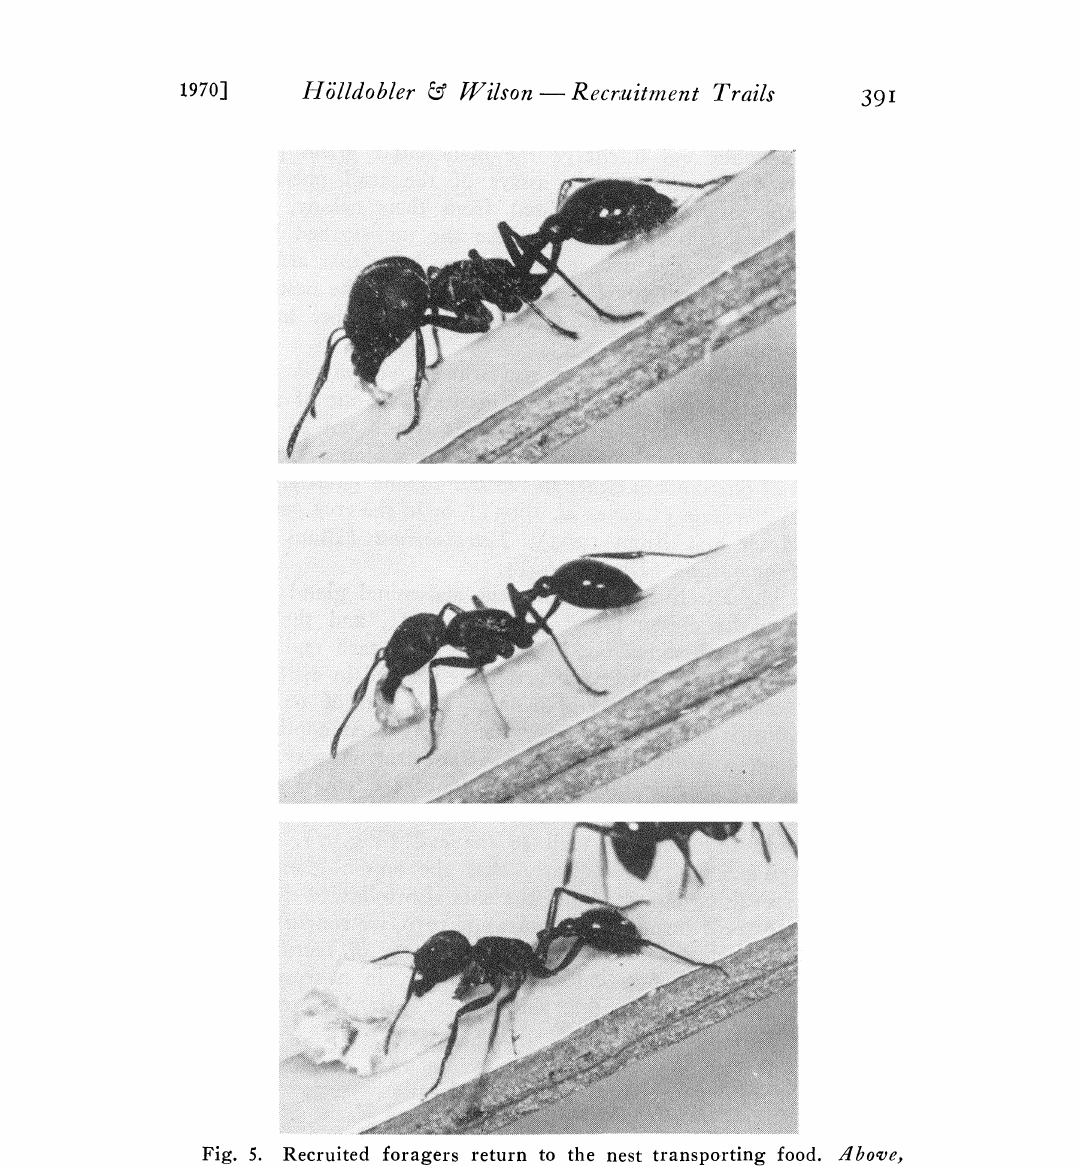
Fig. 5. Recruited foragers return to the nest transporting food. Zlbo,ve, "soldier" (very lai’ge worker) with extruded sting and carrying cockroach fragment; middle, smaller worker with extruded sting, carrying cockroach fragment; belo,w, smaller worker with oat flake, no sting